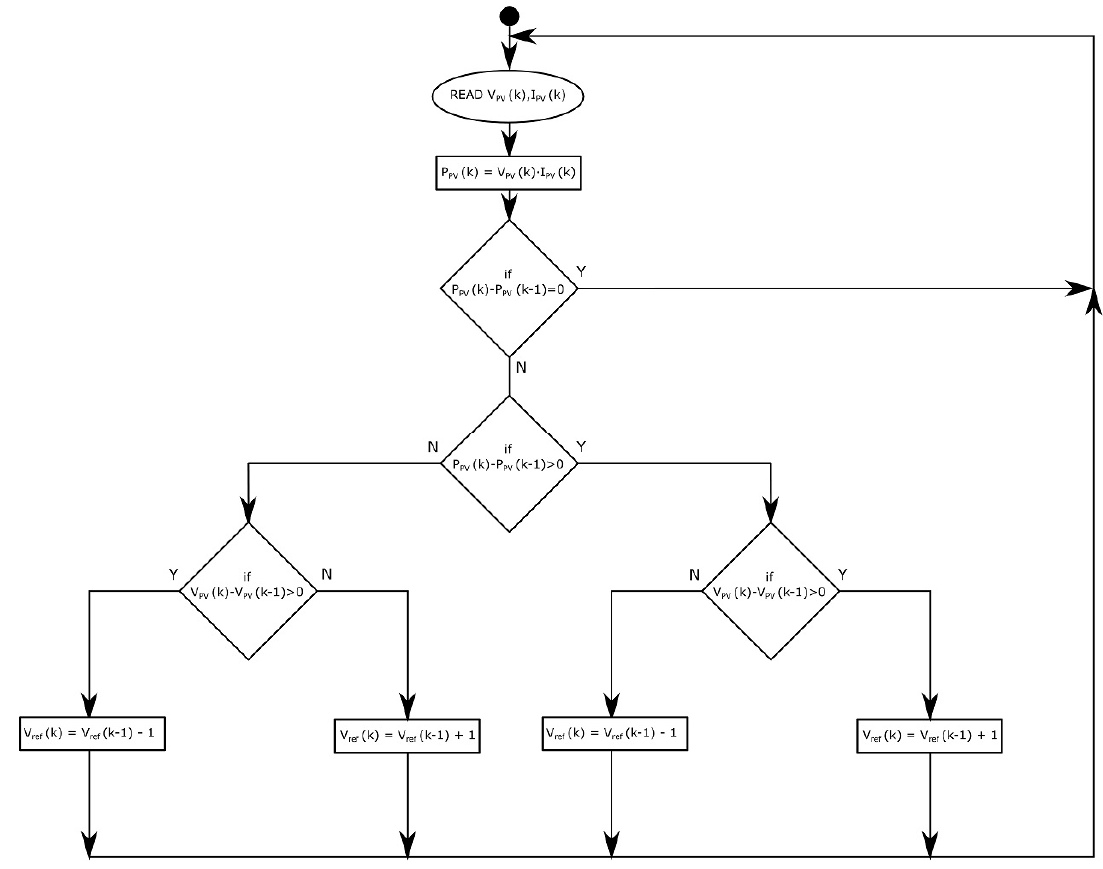
Figure 8. Basic P&O algorithm, according to [16].